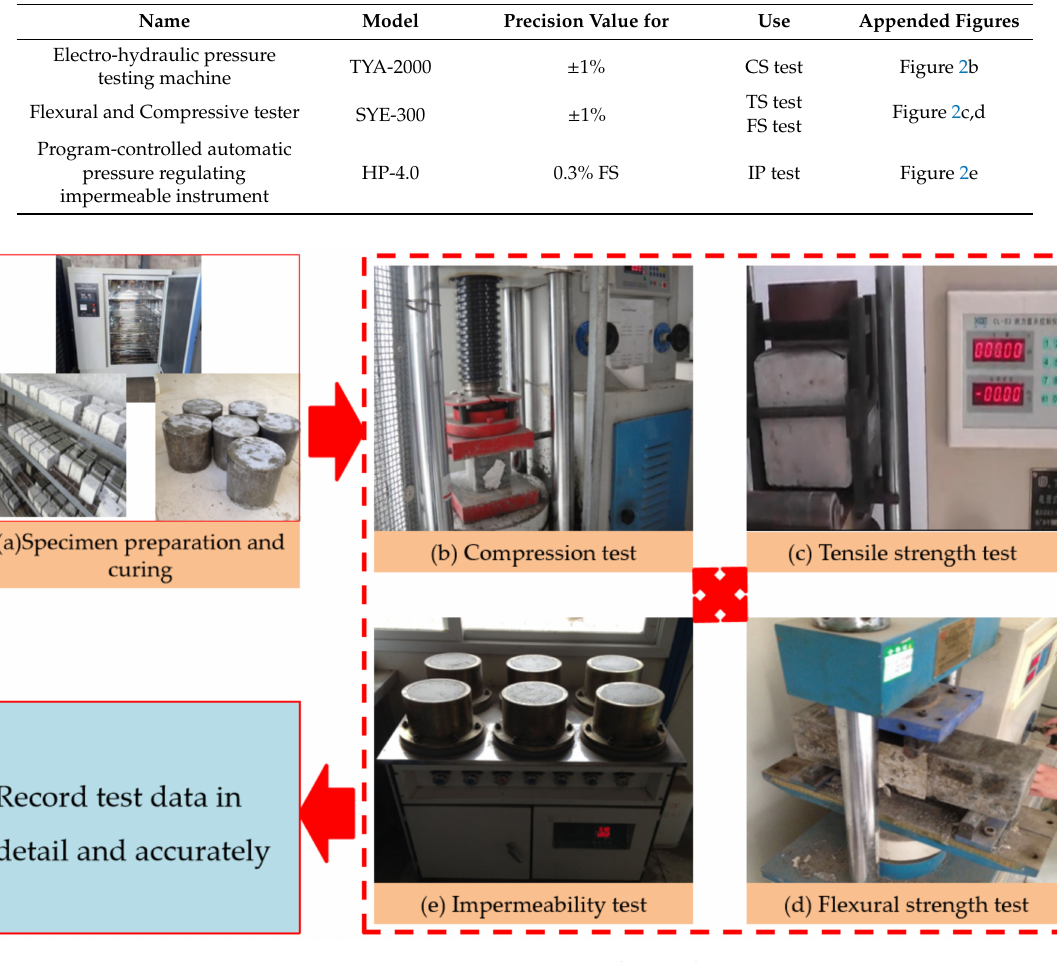
Figure 2. Test arrangement and